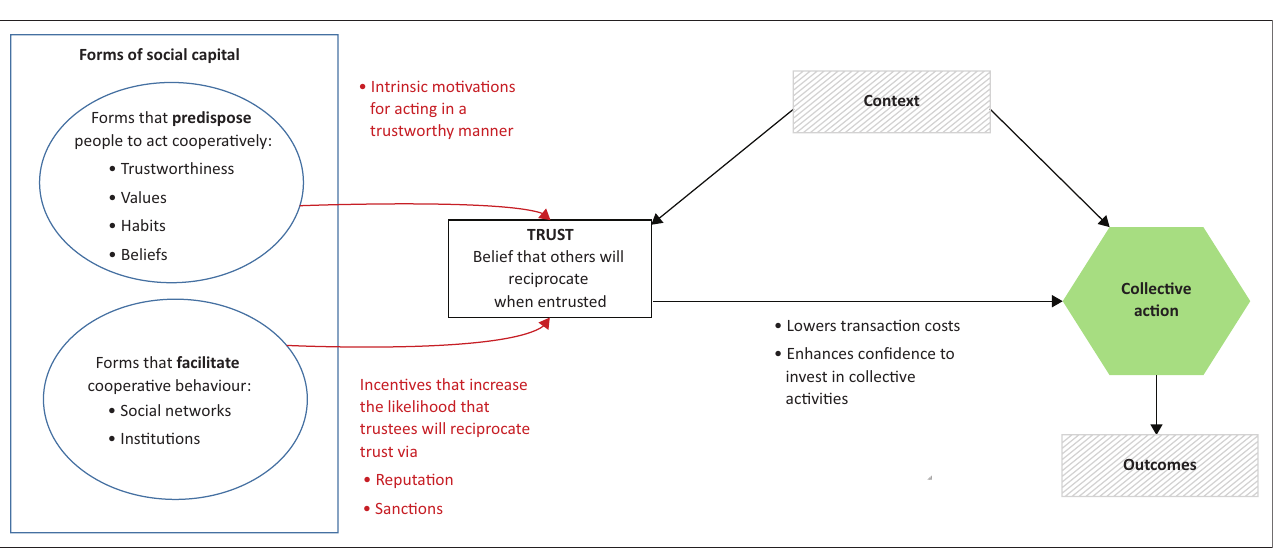
FIGURE 1 : A conceptual model showing how forms of social capital generate collective